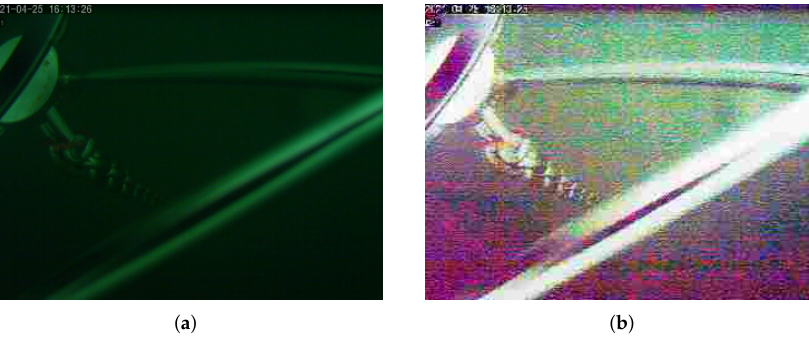
Figure 16. Comparison of the original image with the processed image. ( a ) the original image which take in the underwater environment. ( b ) the processed image which shown in the shore-based